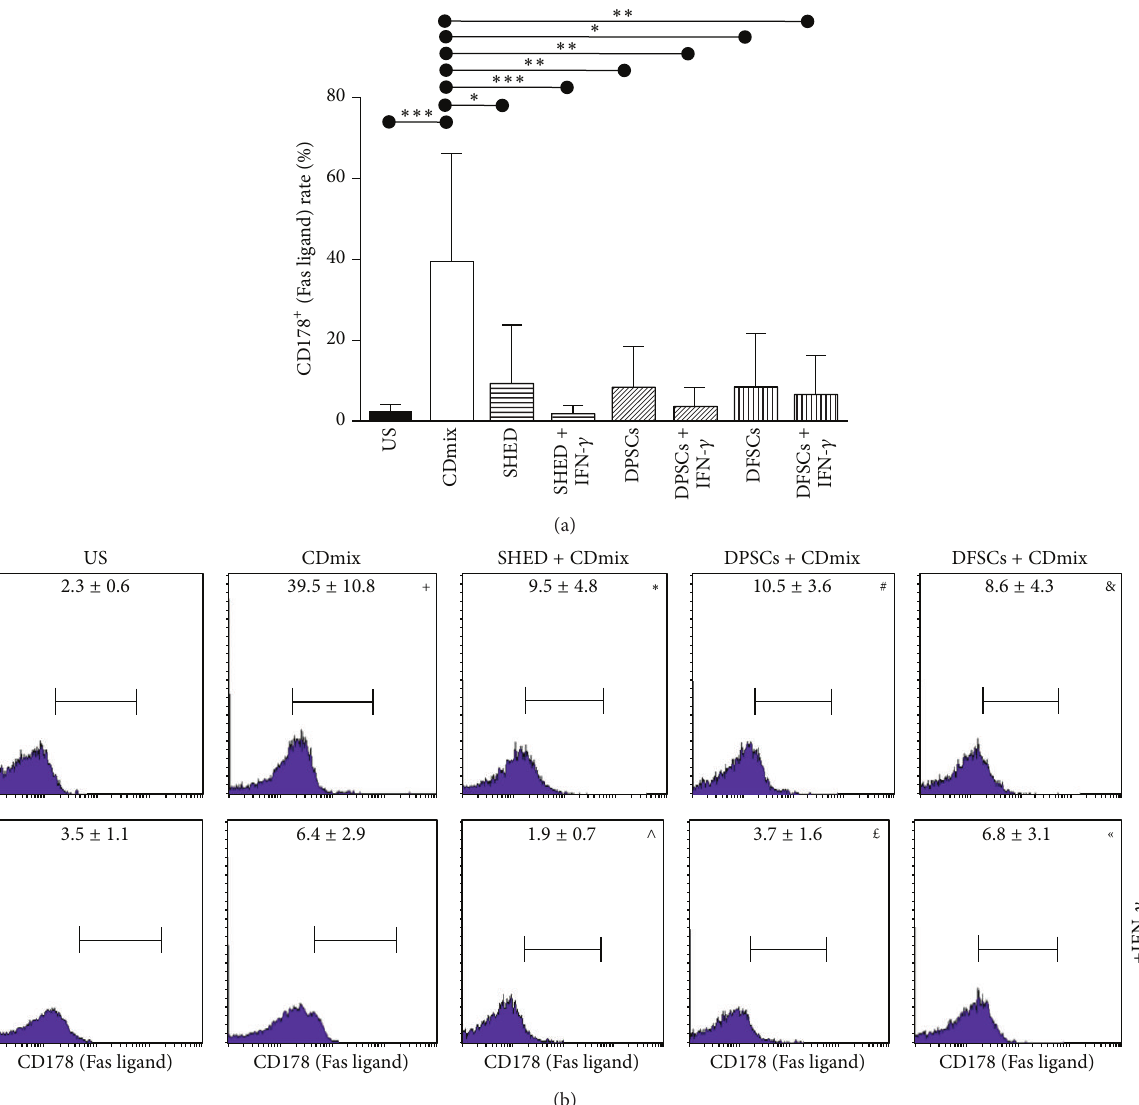
Figure7:InhibitoryeffectofSHED,DPSCs,andDFSCsontheapoptosisoflymphocytesasdetectedbyFas/FasLigandkit.(a)Inhibitoryeffect of SHED, DPSCs, and DFSCs on Fas ligand (CD178) rate of lymphocytes displayed statistically. (b) Inhibitory effect of SHED, DPSCs, and DFSCs on Fas ligand (CD178) rate of lymphocytes displayed by flow cytometry. + 𝑃 < 0.001 , compared with US group. ∗ 𝑃 < 0.05 , compared with CDmix group. # 𝑃 < 0.01 , compared with CDmix group. & 𝑃 < 0.05 , compared with CDmix group. ∧ 𝑃 < 0.001 , compared with CDmix group. m 𝑃 < 0.01 , compared with CDmix group. « 𝑃 < 0.01 , compared with CDmix